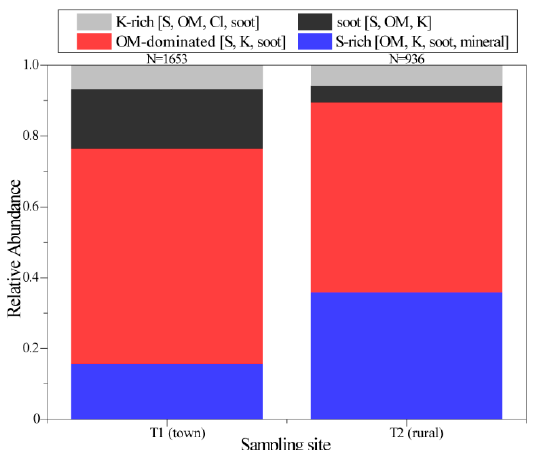
Figure 5. Relative abundance of aerosol particles at the T1 site and T2 site. Number (N) of the analyzed aerosol particles is shown above each column. The bracket indicates that individual particle possibly contained other particle components.